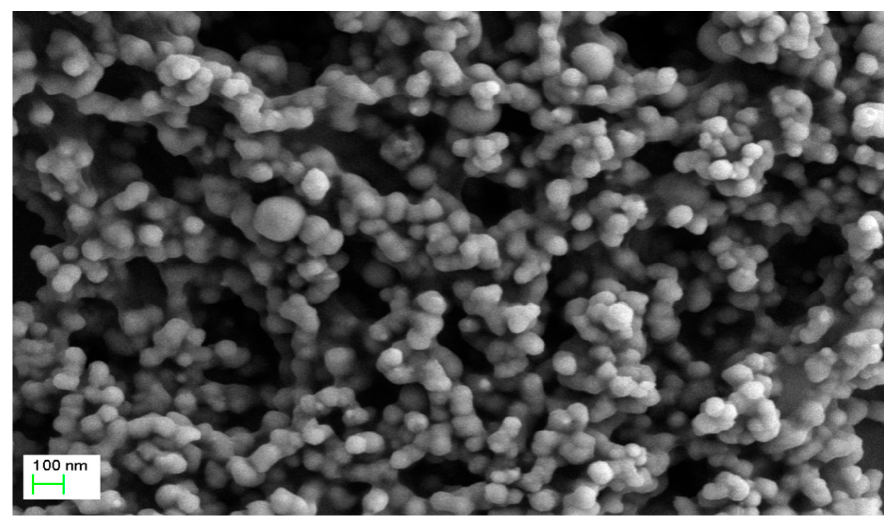
Figure 2. SEM image of n Fe prepared using green tea extract. Conditions: accelerating voltage of 3 kV and indicated magnification of 20k×.